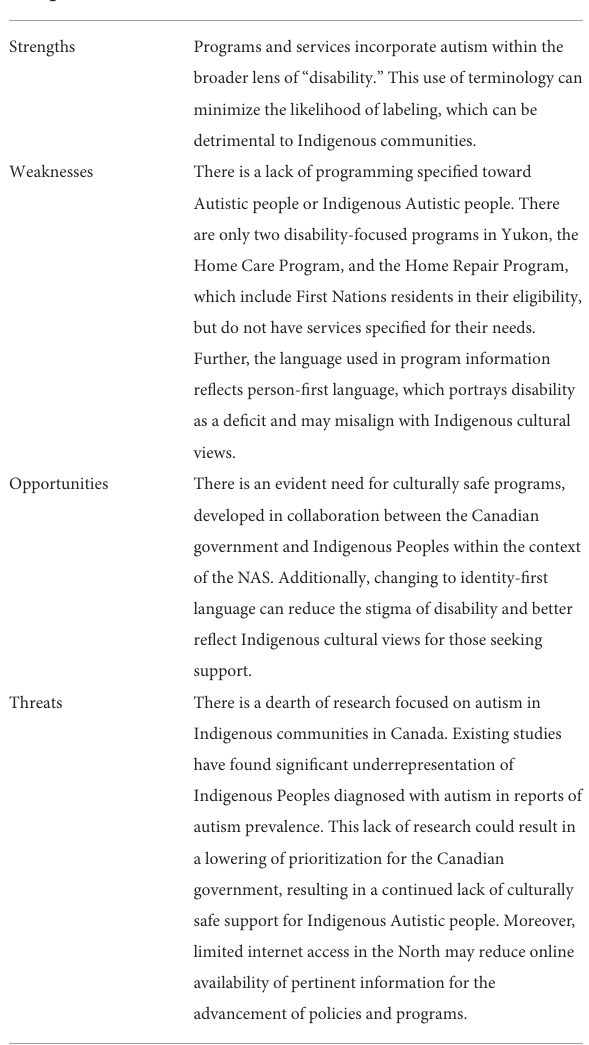
TABLE 2 Summary of S.W.O.T analysis for gray literature search on the perspectives and experiences of indigenous peoples in Canada with autism and